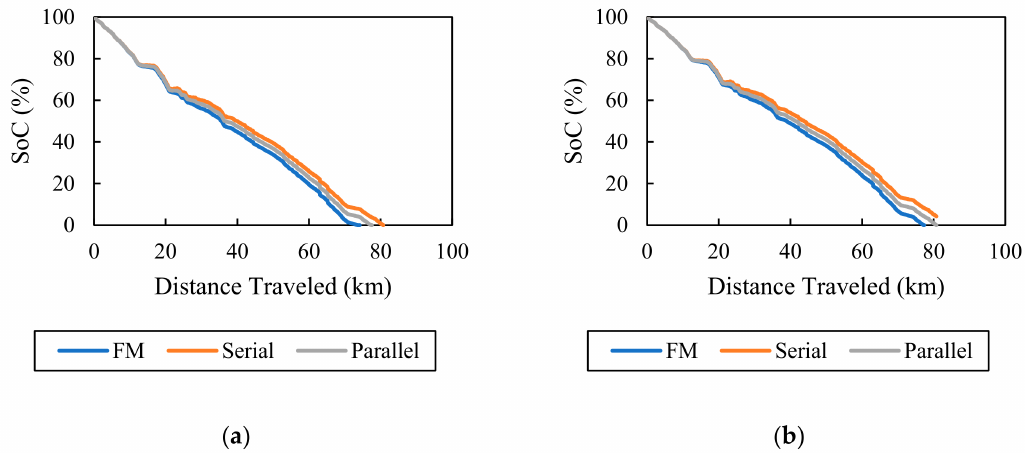
Figure 11. SoC vs. distance graph of ( a ) non-RE LFP and ( b ) non-RE NCA battery configuration for the complete